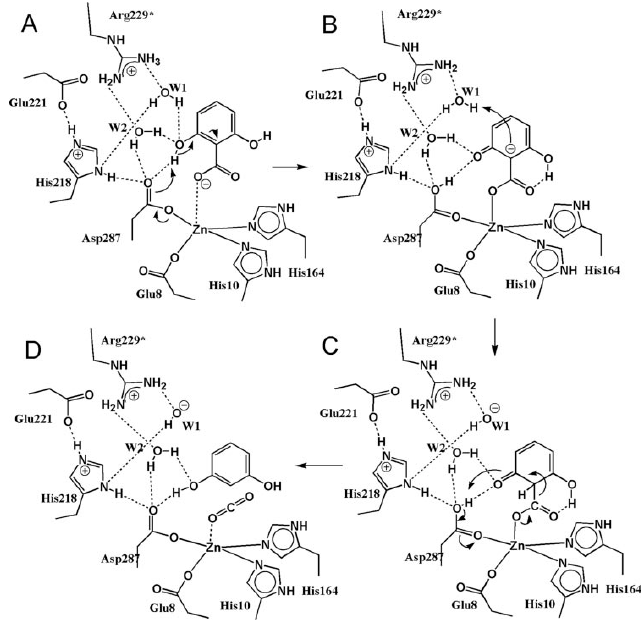
Figure 9. Schematic diagram showing the 2,6-dihydroxybenzoate decarboxylase active site. ( A ) Coordination environment of Zn 2+ with the 2,6-dihydroxybenzoate ligand; ( B , C , D ) representation of intermediates formed during the decarboxylation reaction Reproduced with permission from [74]. Copyright 2006, American Society for Biochemistry and Molecular Biology.